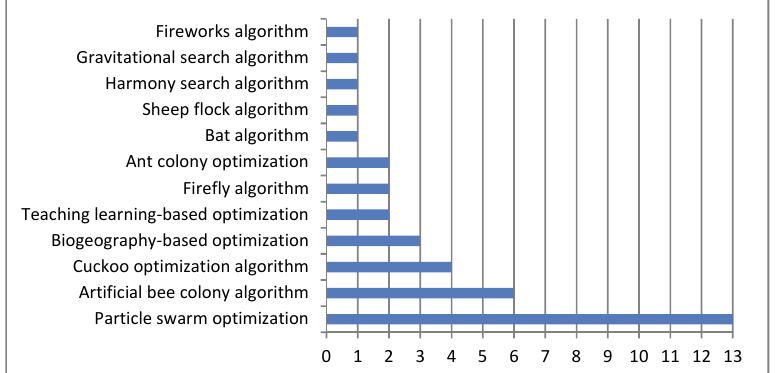
Fig. 11 Applications of different advanced optimization methods for parametric optimization of NTM